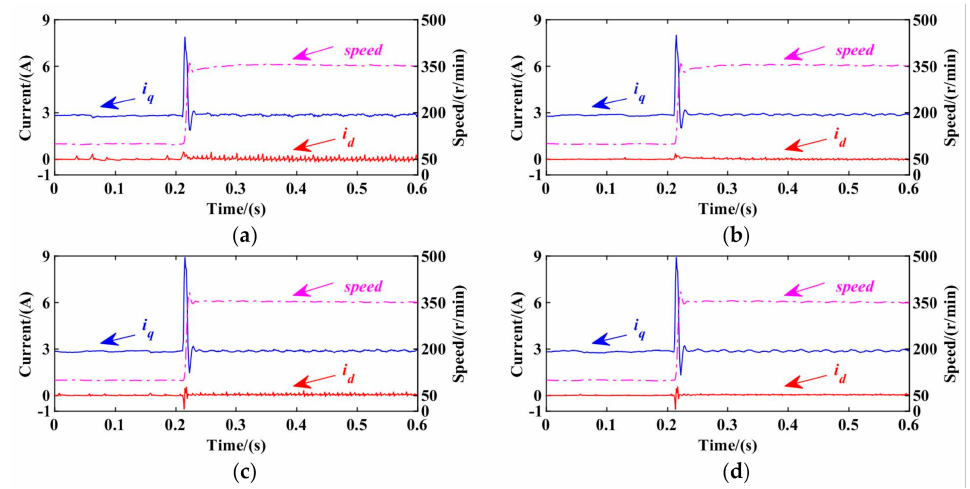
Figure 16. Currents and rotor speed during step response and 1.5 N · m load. ( a ) Compensation for PMSM FOC system with conventional DM–CZD. ( b ) Compensation for PMSM FOC system with proposed DP–CZD. ( c ) Compensation for current predictive control of PMSM with conventional DM–CZD. ( d ) Compensation for current predictive control of PMSM with proposed DP–CZD.